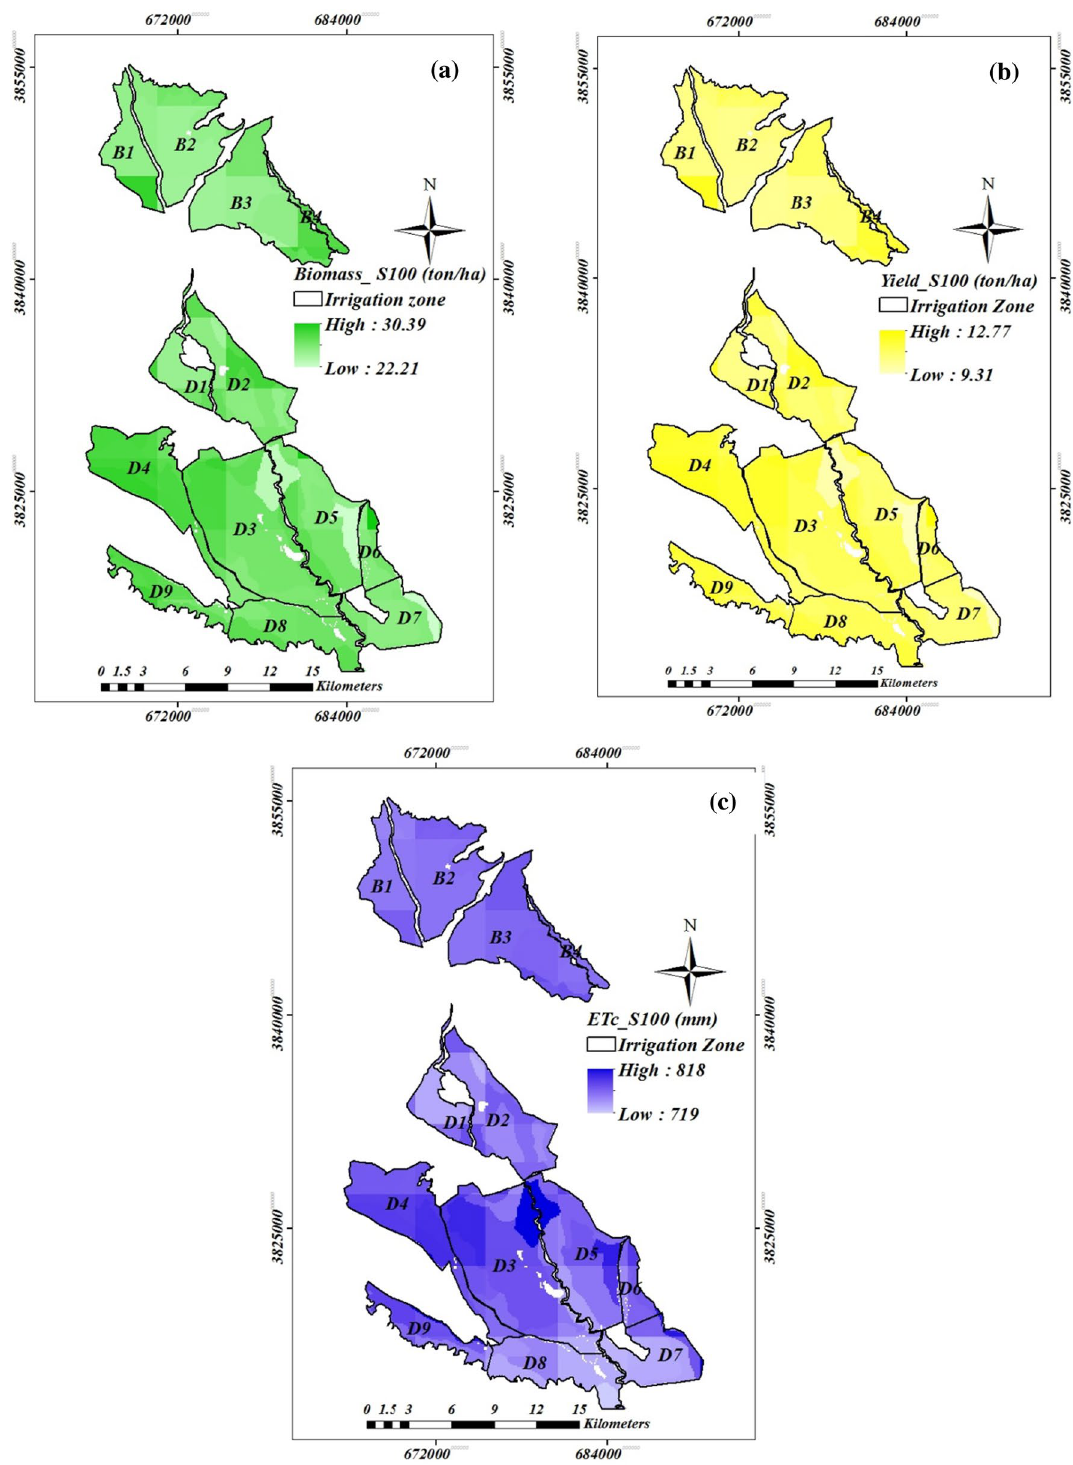
Fig. 7 Average spatial changes of biomass yield ( a ), grain yield ( b ), and seasonal evapotranspiration ( c ) of maize in S100